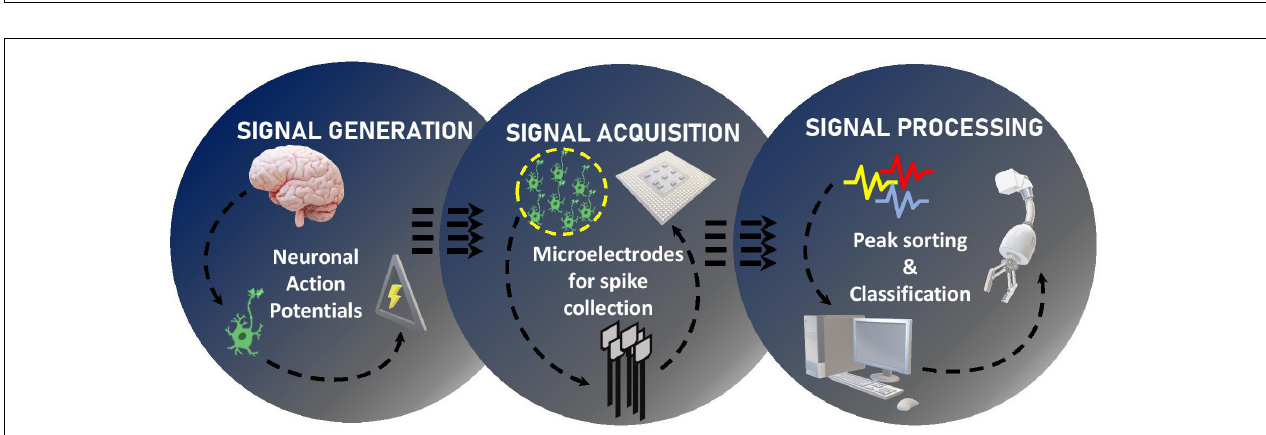
FIGURE 3 | Schematic outline of this review on the three main domains in the research and development of brain machine interfaces.